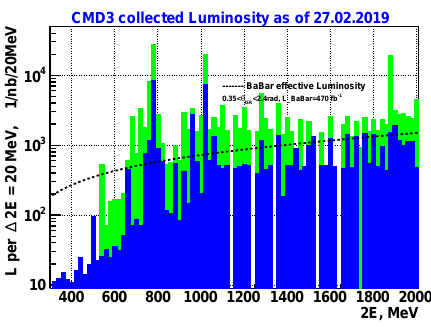
CMD3 collected Luminosity as of 27.02.2019